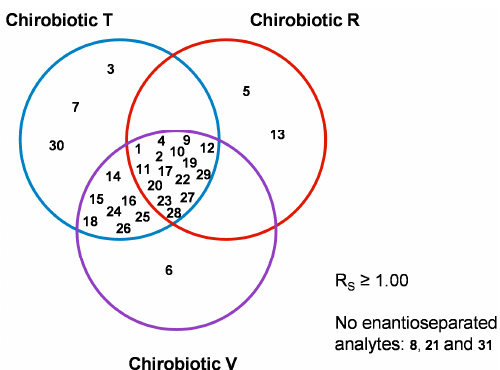
Figure 6. Diagram considering the xanthonic analytes enantioseparated by Chirobiotic TM T, R and V columns, with resolution factors ≥ 1.00. Chirobiotic TM TAG was not included considering its poor enantioselectivity for the evaluted analytes.